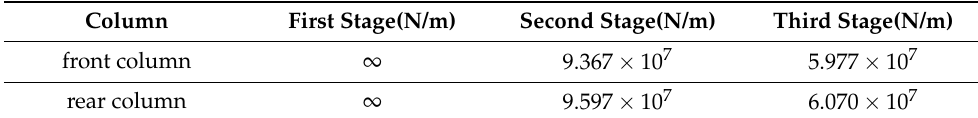
Table 3. Equivalent stiffness of columns in different stages.